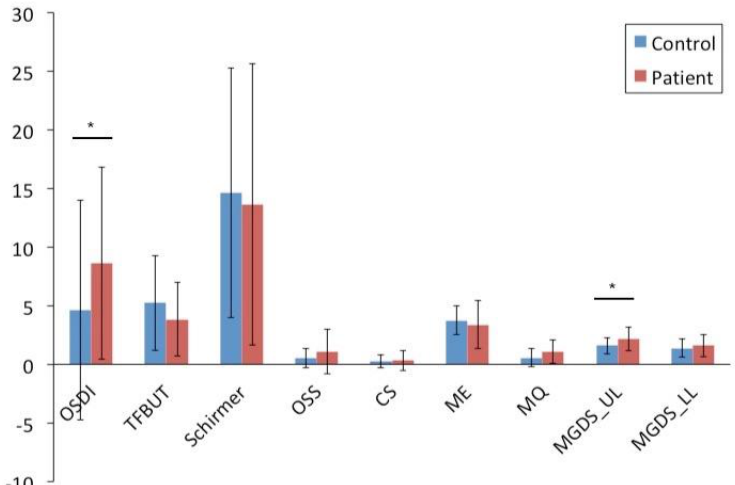
Figure 5. Clinical dry eye tests in patients and healthy individuals. Radiated patients show significantly more severe subjective dry eye symptoms when compared to controls, as indicated by a higher Ocular Surface Disease Index (OSDI) score, and significantly higher meibomian gland dropout score on the upper lid (MGDS_UL). Other ocular examinations do not exhibit statistically significant differences between the two groups. OSDI: Ocular Surface Disease Index questionnaire score; TFBUT: tear film breakup time; OSS: ocular surface staining; CS: corneal staining; ME: meibomian gland expressibility; MQ: meibum quality; MGDS: meibomian gland dropout score; UL: upper lid; LL: lower lid. The x-axis includes the clinical ocular evaluations conducted. The y-axis illustrates the different scores attained from these examinations. * represents p < 0.05.